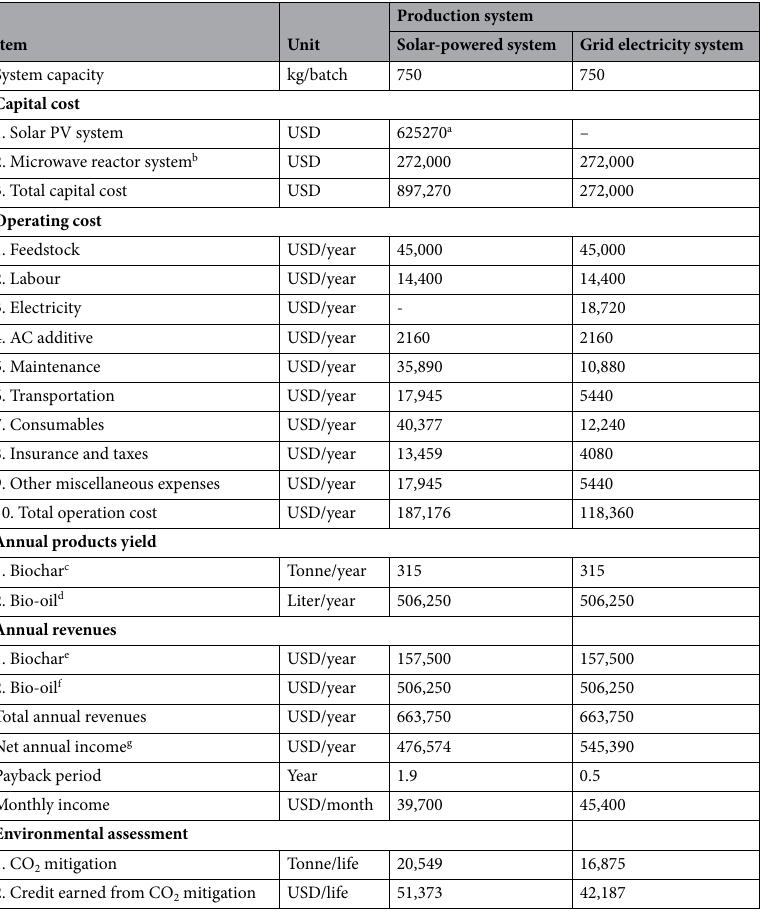
Table 6. Techno-economic and environmental assessment for scaling-up microwave pyrolysis production system of corn stover. [ a Based on Table 5, b Total cost of the microwave pyrolysis system include the reactor, microwave system, condensation system, N 2 gas, and temperature monitoring system was estimated based on previous work in microwave pyrolysis 33 , considering 3% escalation factor per year (https:// fred. stlou isfed.